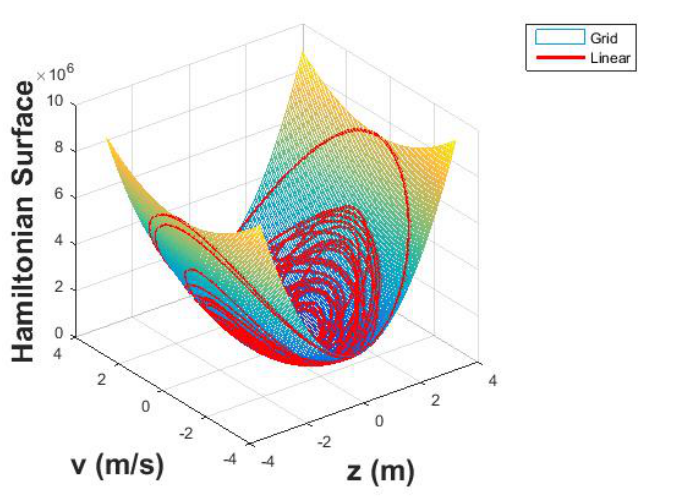
Figure 23. Hamiltonian surface for the linear WEC in an irregular